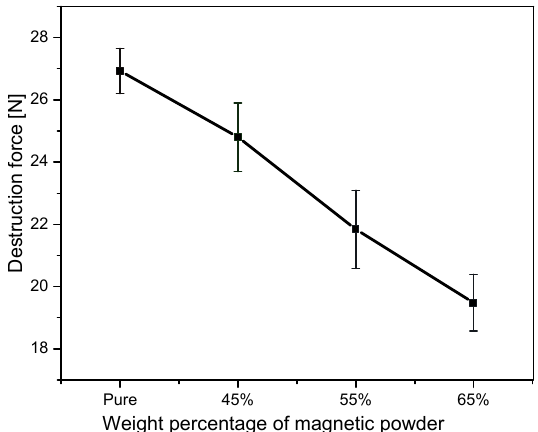
Figure 9. Mechanical stability of the AW4510 based PMC sample posts fabricated on an FR4 substrate. The error bars denote the standard deviation of 5